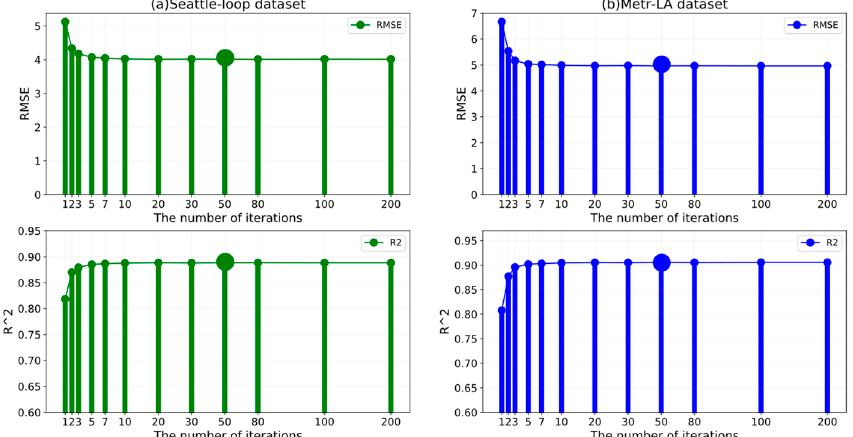
Figure 8. The number of iterations of the ST-CRMF model on the Seattle-Loop and METR-LA da- tasets.